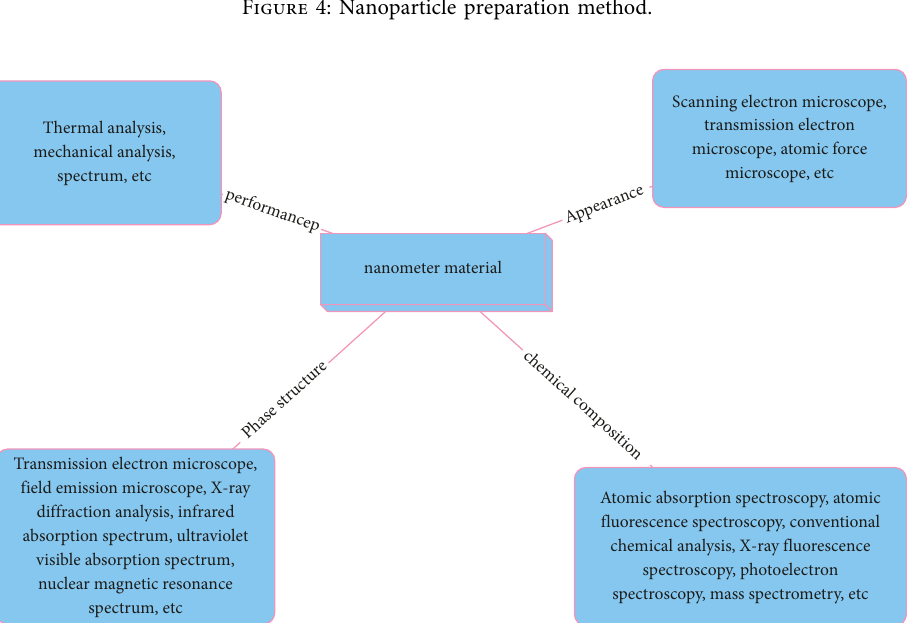
Figure 4: Nanoparticle preparation